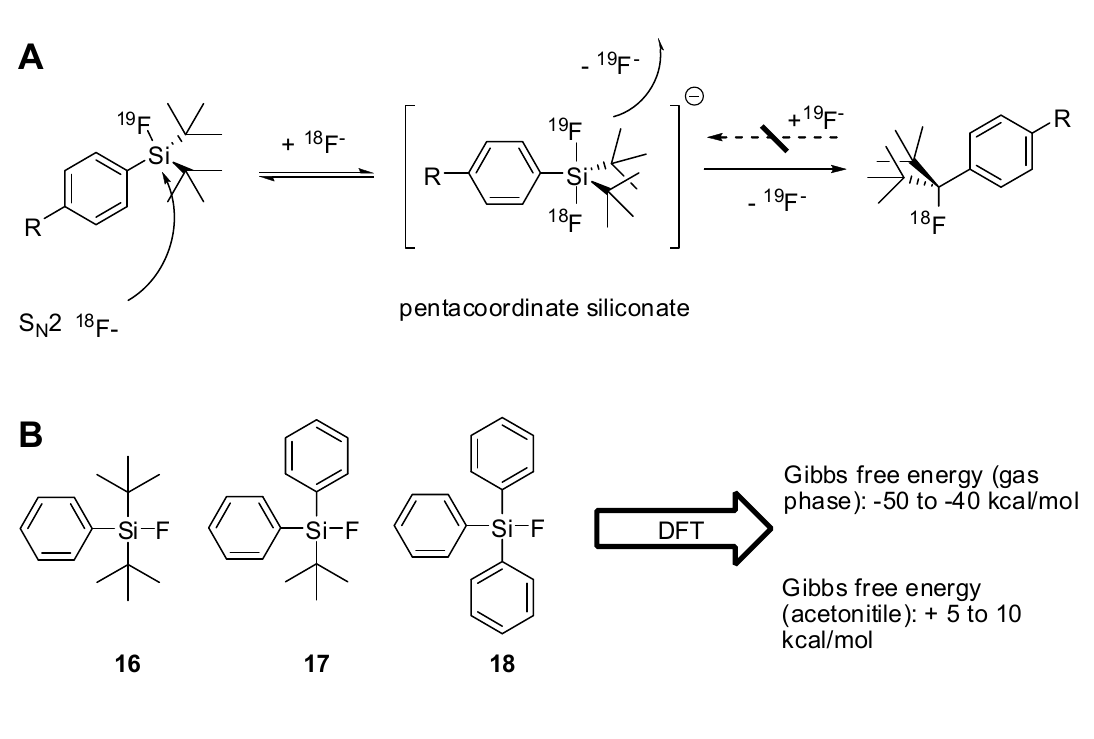
Figure 5. ( A ) Isotopic exchange mechanism resulting in a pentacoordinated silicon intermediate. The back-reaction yielding the original 19 F-SiFA compound is statistically not favored. ( B ) Density Functional Theory calculations on three model SiFAs result in a Gibbs free energy of − 50 to − 40 kcal/mol in gas phase and +5 to 10 kcal/mol in